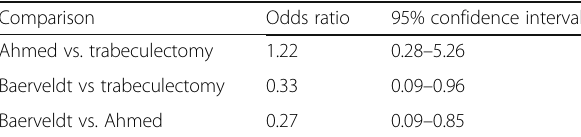
Table 8 Odds ratio of failure